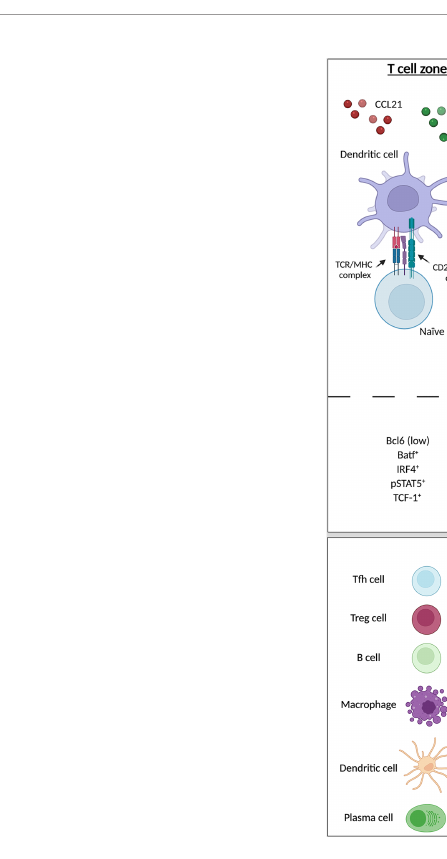
FIGURE 1 | Differentiation, maturation of Tfh and germinal center organization. Tfh differentiation progressively occurs in three different zones: the T cell zone, the B cell zone, and the germinal center (GC). From the T cell zone to the GC, naïve CD4 + T cells differentiate into Tfh with fi nal maturation occurring within the GC. In the T cell zone interactions between CD4 + naïve T cells and dendritic cells (DC) initiate Tfh differentiation and promote the release of IL-6, IL-21, and the upregulation of CXCR5 on the pre-Tfh. These pro-Tfh cytokines result in the release of CXCL13 by follicular dendric cells (FDCs) and CXCL12 by CXCL12-producing reticular cells (CRCs) in the B cell zone. Recognition of CXCR5 by CXCL13 results in recruitment of the immature Tfh into the B cell zone. Both CXCR5 and ICOS signaling promote homing of the now-mature Tfh into the GC. Interactions with B cells in the GC result in the maturation of B cells into plasma cells for the production of antibodies. During these three stages of Tfh differentiation the transcriptional environment changes as differentiation progresses. Initially expression Bcl6 is low, and the pre-Tfh cell enhances expression of Batf, IRF1, pSTAT5, and TCF-1. During the second stage of development Bcl6 expression remains low while pSTAT3, Tbet, and RORg increase in expression. In the fi nal stage of Tfh maturation Bcl6 is now highly expressed, while suppression of Tbet, GATA3, RORg, pSTAT5, and Blimp1 are suppressed. The GC is comprised of three zones: the mantle zone, light zone, and dark zone. The light zone primarily houses T cells and the majority of T:B cell interactions occur here. Within the dark zone B cells undergo somatic hyper mutation (SHM) for differentiation into plasma cells and long-lived memory B cells. Created with